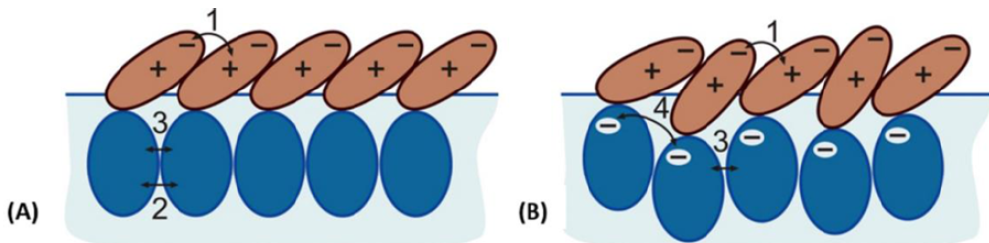
Figure 7. Proposed arrangement of β -aescin molecules of ( A ) neutral and ( B ) ionized molecules in a surface cluster adsorbed at a water-vacuum interface, as obtained from MD simulations. The numbers 1–4 indicate the main inter-molecular forces dominating the β -aescin self-assembly.